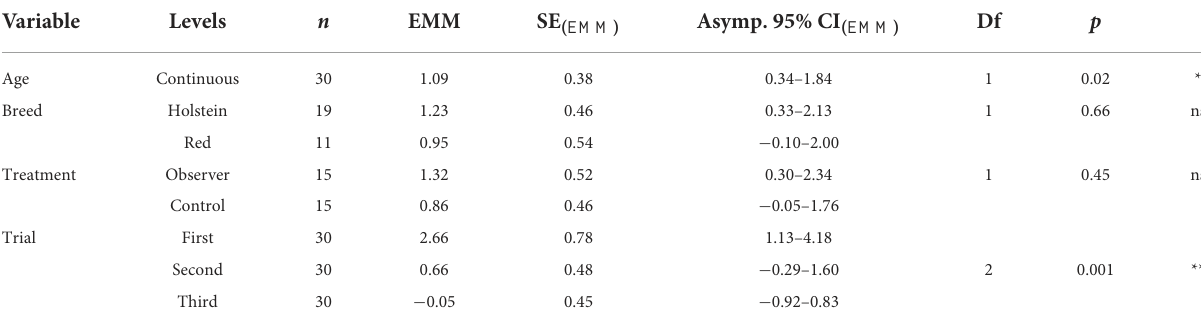
TABLE 1 Summary of the mixed-effects logistic regression on success of solving detour task regardless of route. Variable